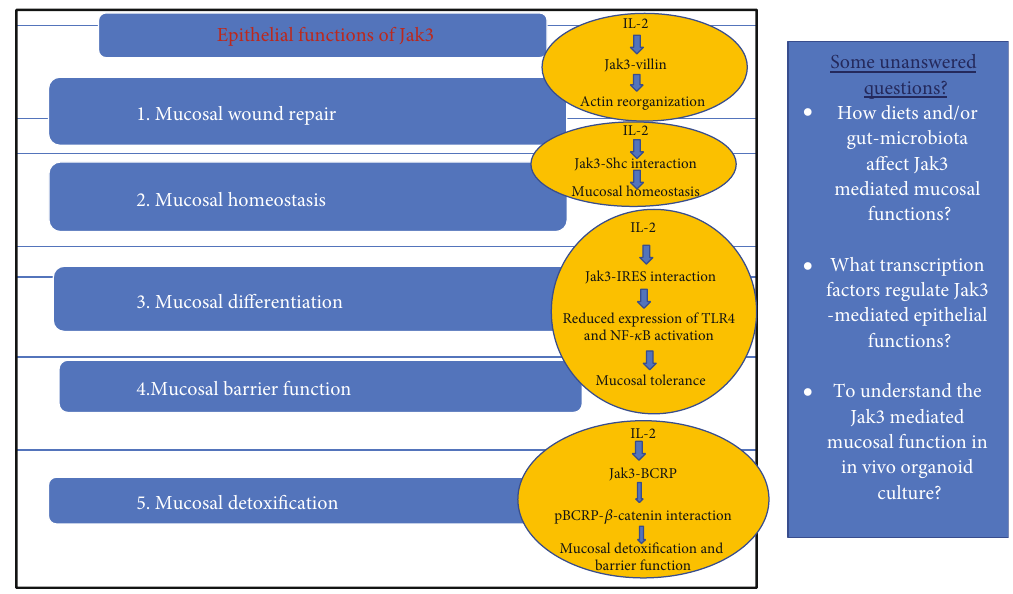
Figure 9: Epithelial functions of Jak3 and some unanswered